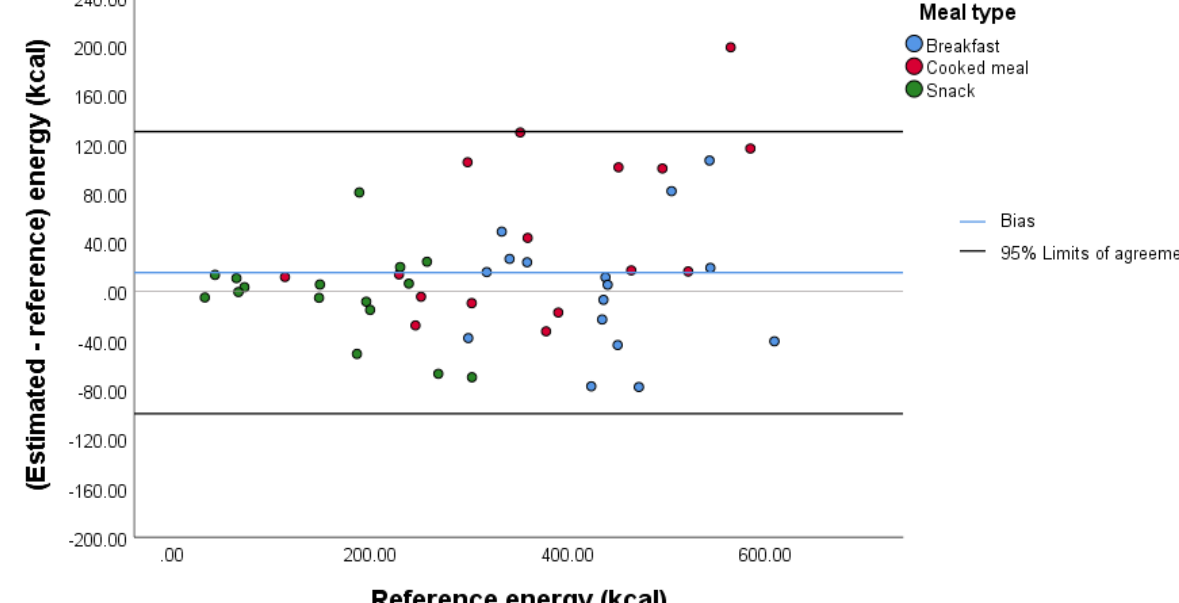
Figure 6. Bland-Altman plot illustrating the difference between the estimated and reference energy content of the